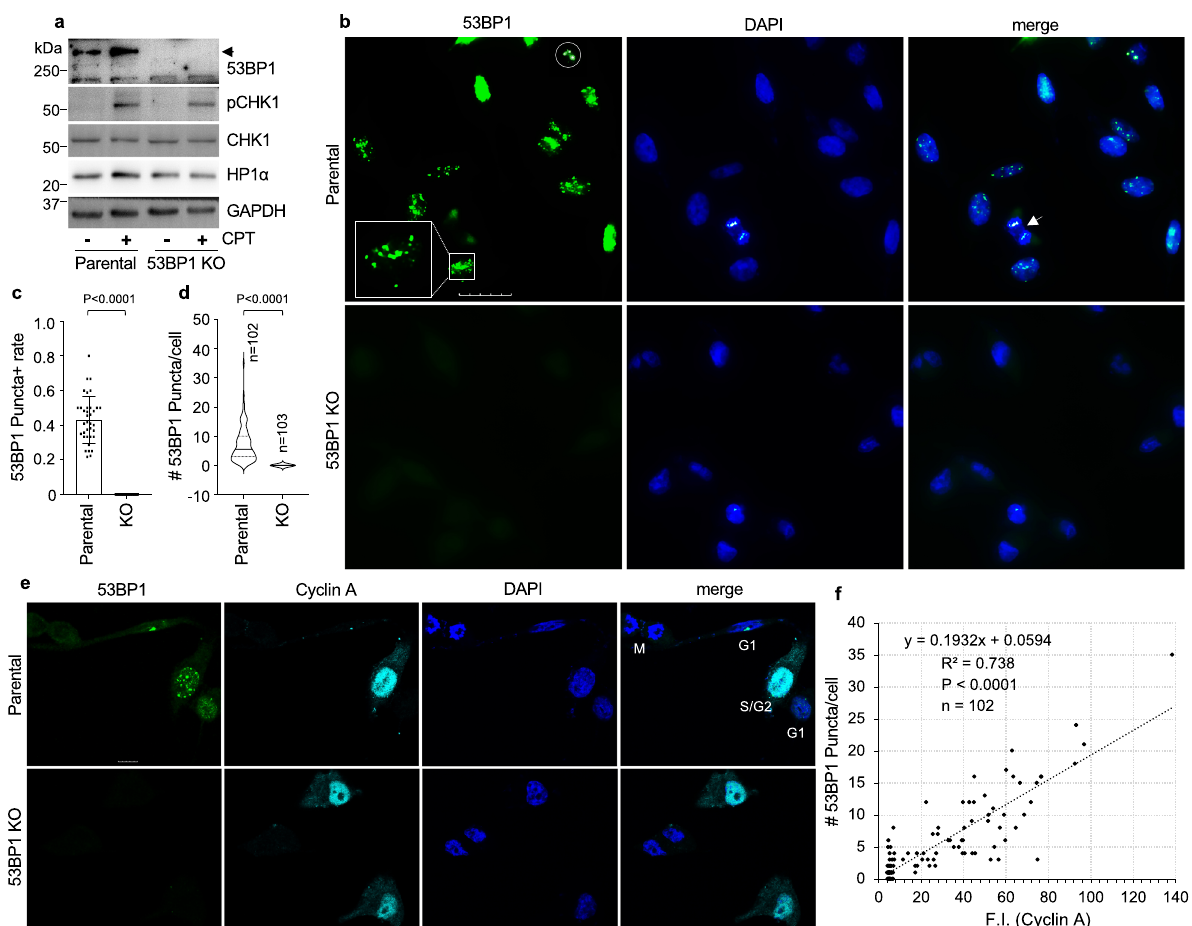
Fig. 1 53BP1 forms nuclear puncta. a MDA-MB-231 parental and 53BP1 knockout (KO) cells were treated or not with 500 nM CPT for 6 h, and protein expression was detected. Arrowhead indicates 53BP1. b Representative images of nuclear localization of 53BP1 in MDA-MB-231 cells under normal growth conditions. Single z-plane images were acquired by sequential scanning using confocal microscopy. Square : an example of puncta + cell; Circle: a cell with three spontaneous 53BP1 foci; Arrow: a mitotic cell. Scale bar is 16 μ m. c Percentage of puncta positive cells were analyzed from n = 36 individual images taken from four replicate experiments with a total n = 447 and 373 cells analyzed for parental and KO groups, respectively. Data represent mean values and standard deviation (SD). d Violin plot of 53BP1 puncta number per cell was analyzed from n = 185 and 105 parental and 53BP1 KO MDA-MB-231 cells, respectively. Data represent mean, 25th, and 75th percentiles with the whiskers extending to the minimum and maximum values. e Representative images of 53BP1 puncta and Cyclin A in MDA-MB-231 parental and 53BP1 KO cells under normal growth conditions. The cell cycle stages (G1, S/G2, and M) were determined by a combination of Cyclin A expression levels and DAPI staining patterns. Single z-plane images were acquired by sequential scanning